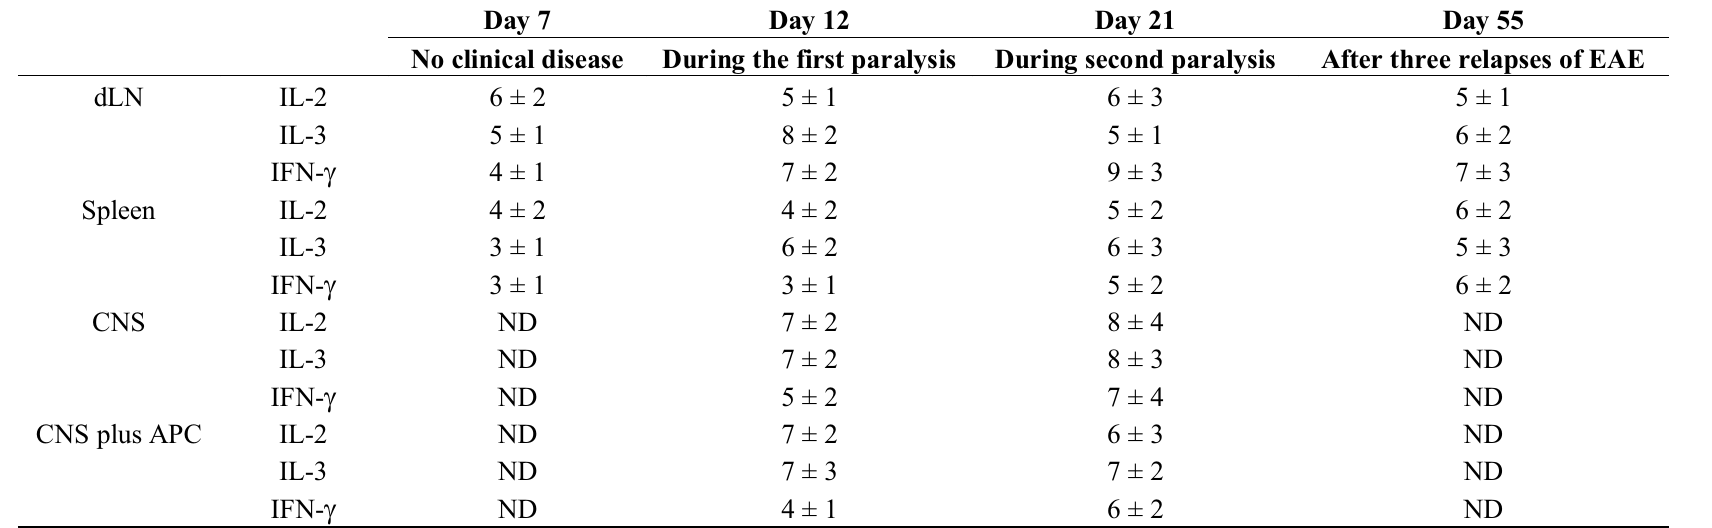
Table 2. Functional avidity (Kf, (cid:80) M) of PLP:139-151-specific CD4 T cells producing IL-2, IL-3 and IFN- (cid:534)(cid:3) (cid:68)(cid:87)(cid:3) (cid:71)(cid:76)(cid:73)(cid:73)(cid:72)(cid:85)(cid:72)(cid:81)(cid:87)(cid:3) (cid:86)(cid:87)(cid:68)(cid:74)(cid:72)(cid:86)(cid:3) (cid:82)(cid:73)(cid:3) chronic-relapsing EAE in SJL mice. ELISPOT assays were preformed at the time points specified with separated CD4 cells (from dLN and Spleen) or unseparated spinal cord cells (the latter were tested with or without added APC, as specified). Legend to Table 1 applies, with the modification that the PLP:139-151-peptide was titrated to establish dose response curves as shown in Figure 4. The Kf values were calculated from the dose response curves as specified in Experimental Procedures . The mean and SD of Kf values are shown from three-five independent experiments for each time